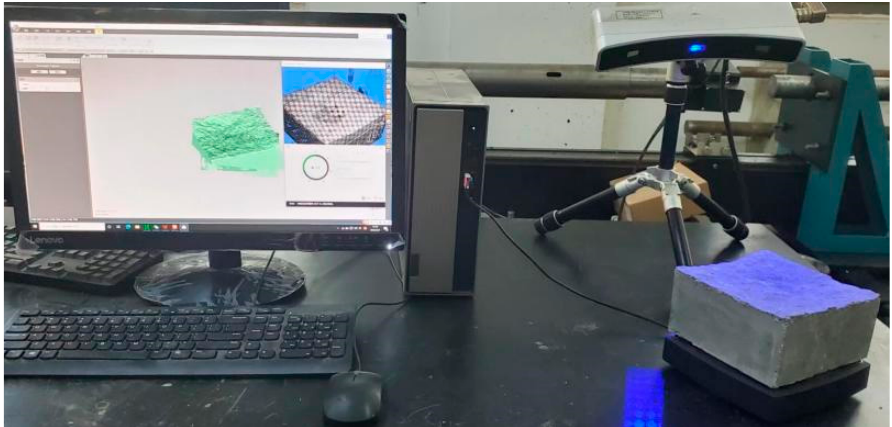
Figure 2. Schematic diagram of a joint surface measured using the 3D scanner.